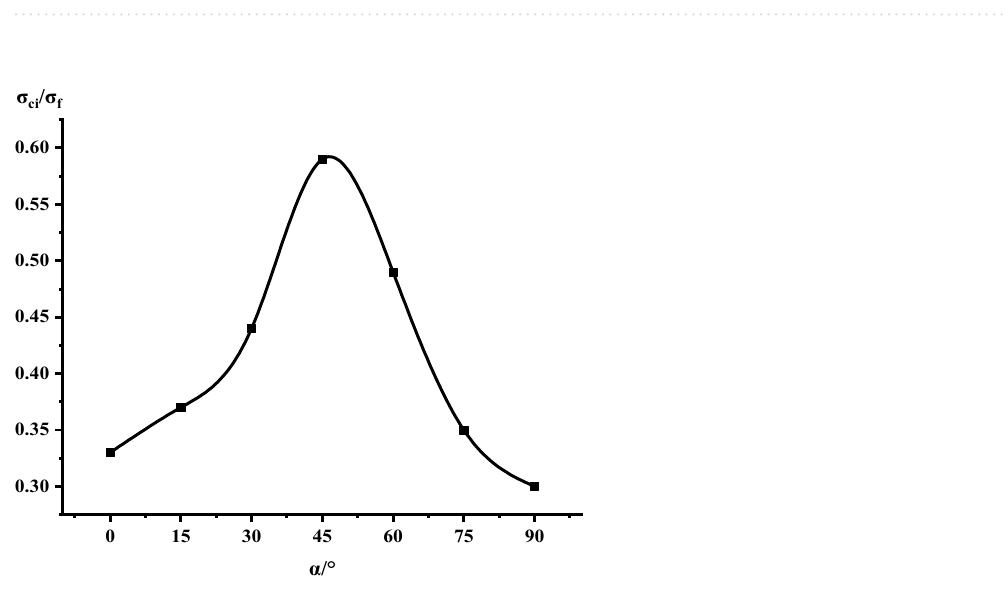
Table 1. Threshold value of dip angle stress of different joints of Phyllite.